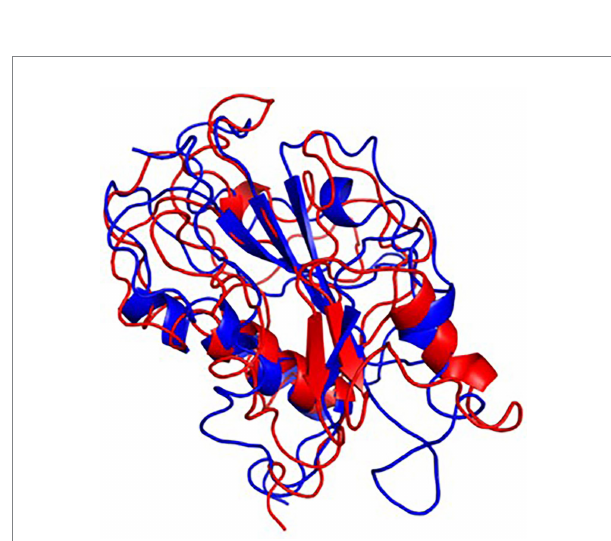
FIGURE 10 Final frame superimposition of the two models: Superimposed final frame of ASP_Indie-C1 (Blue) and ASP_NL4-3